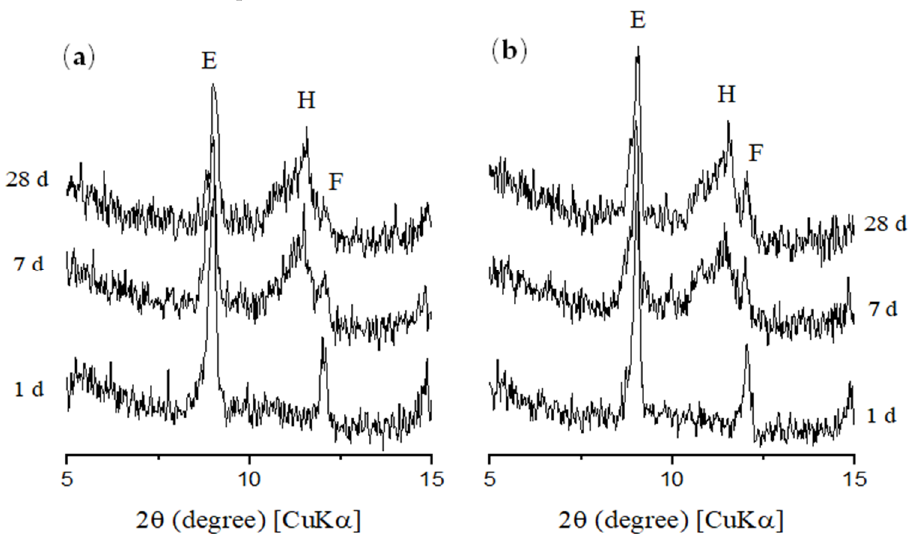
Figure 14. XRD patterns of ( a ) REF and ( b ) 0.05 CNT—A0% at 1, 7 and 28 days (E—ettringite; F—ferrite; H—hemicarbonate).